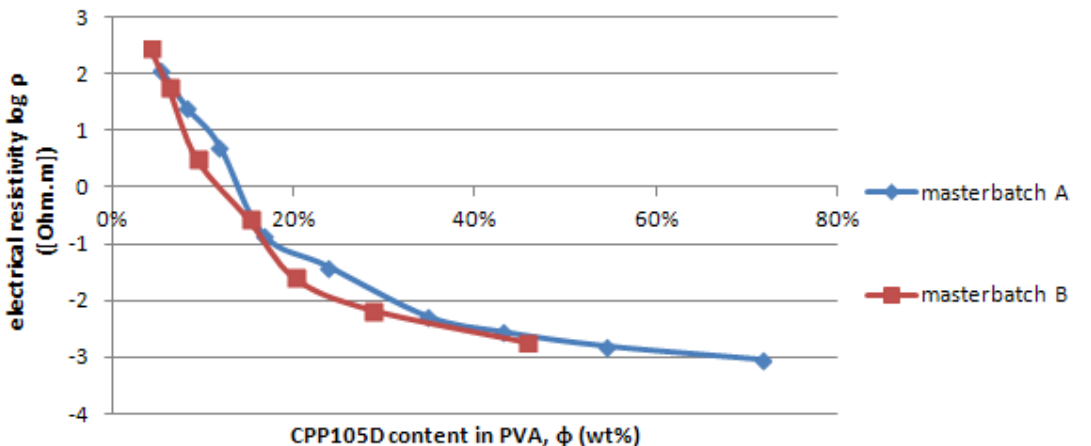
Figure 4. Coating resistivity in function of the dry mass content of CPP105D in